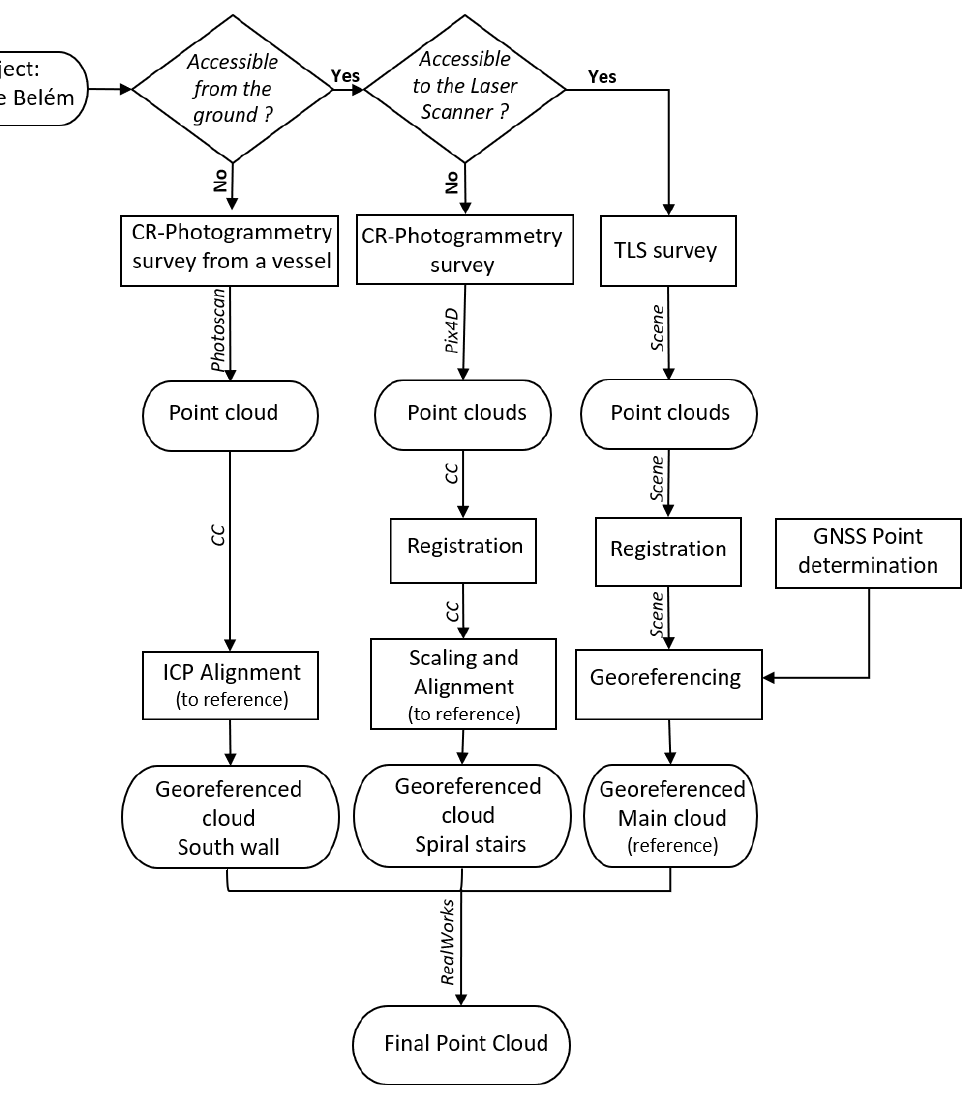
Figure 3. Work methodology applied in the geometric characterization. CC – CloudCompare [42];